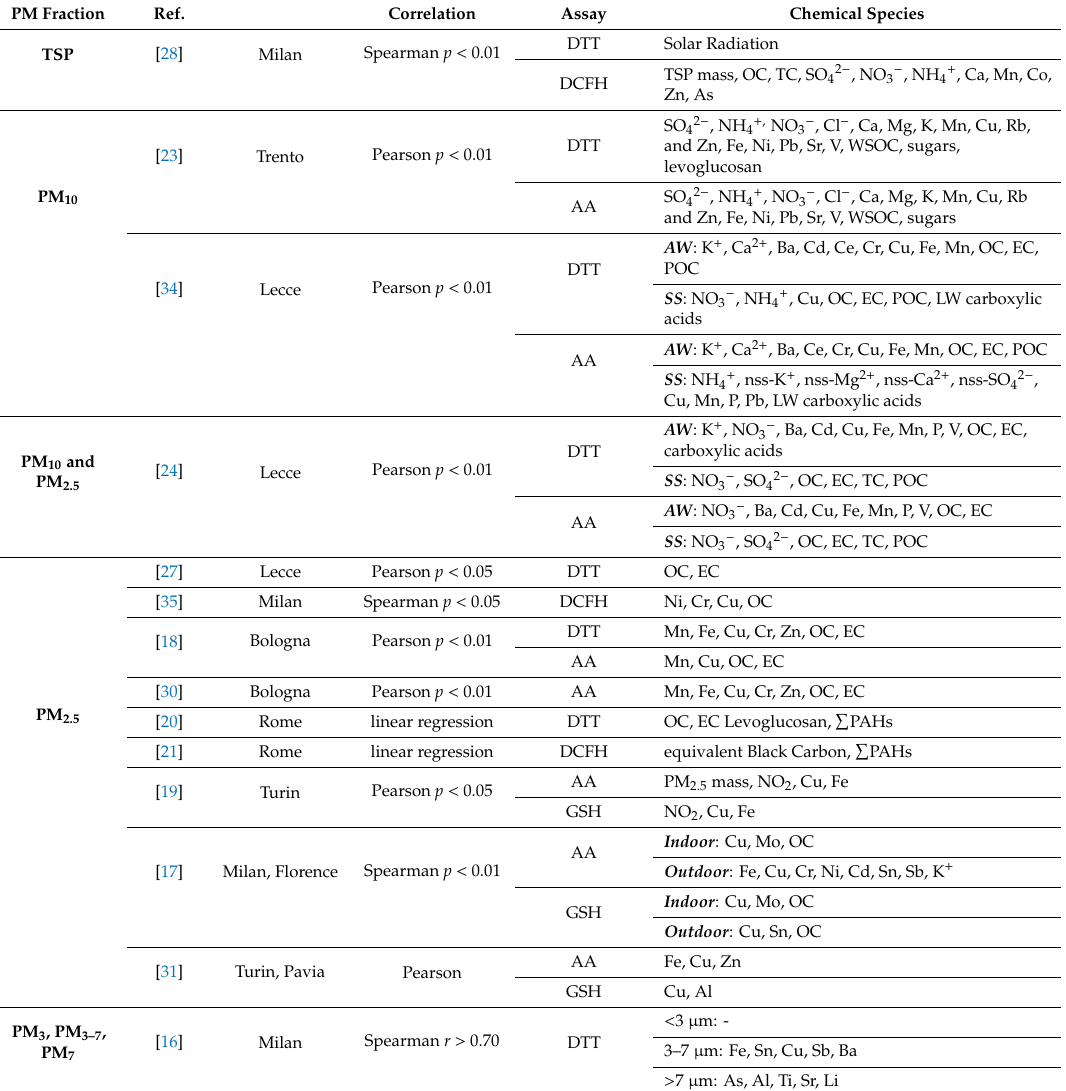
Table 2. Association among the measured OP and chemical composition reported in the reviewed studies, grouped according with PM dimensional fractions: Site location of PM samples collection, correlation analysis used for association at p level, acellular assay used for OP measurement, chemical species showing significant correlation to